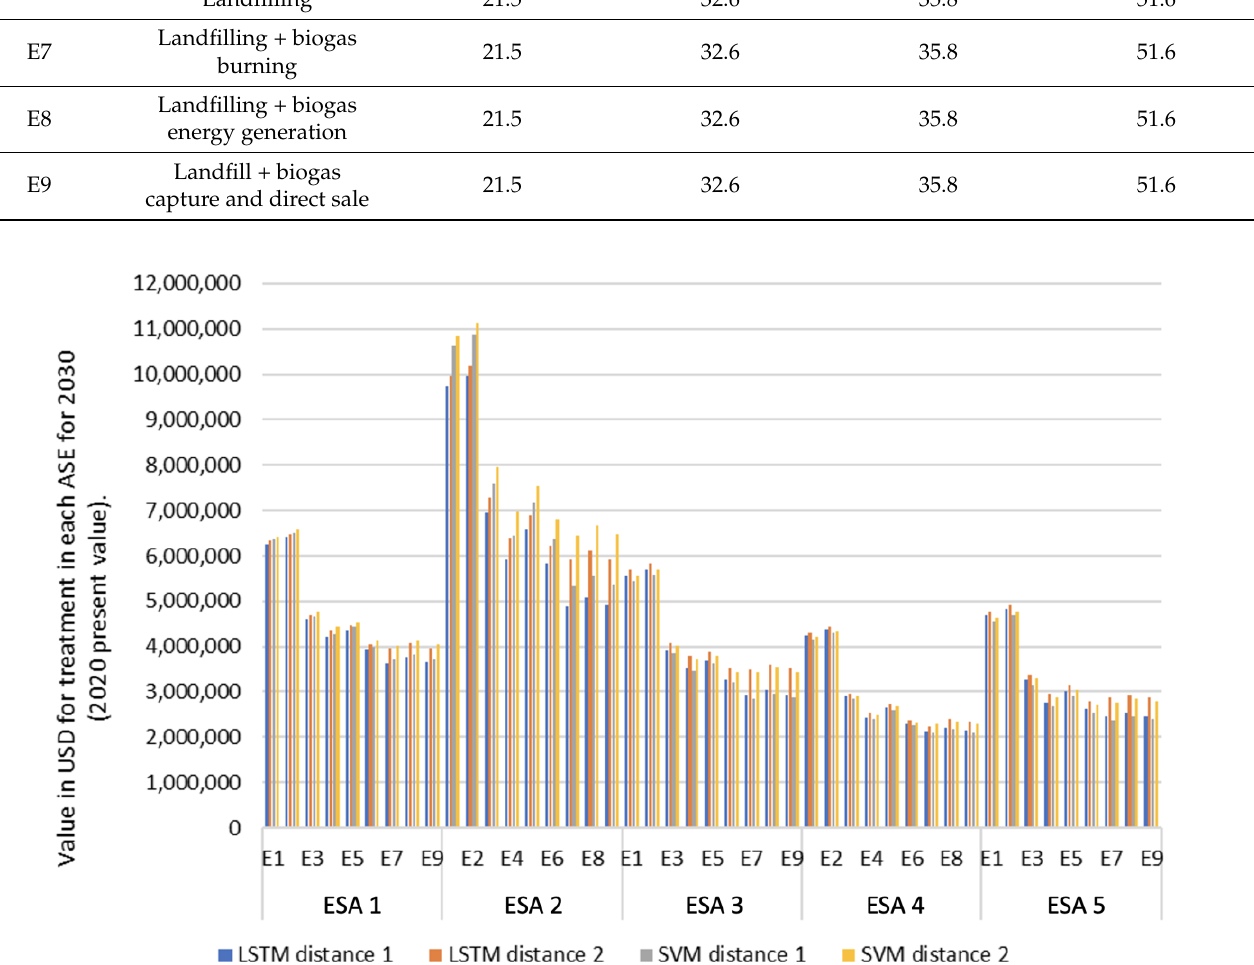
Figure 11. Projected costs for 2030 (monthly average) by ESA, model, scenario and